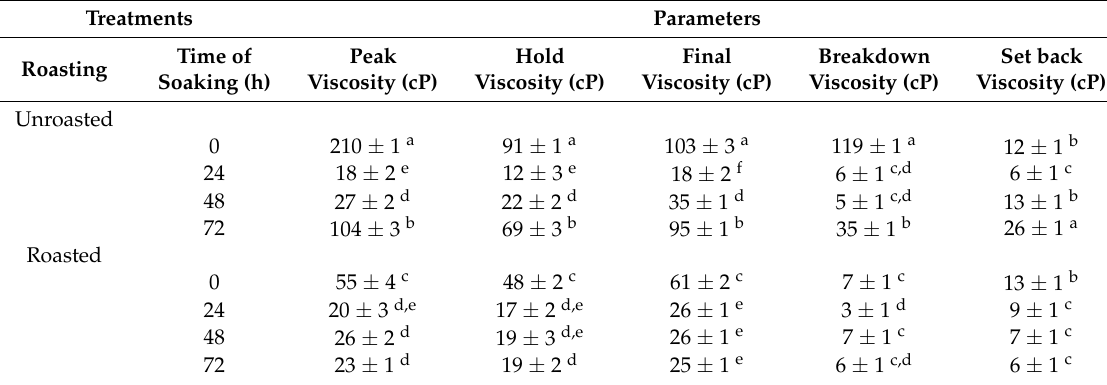
Figure 5. Viscoamylograph profiles of ( A ) unroasted; and ( B ) roasted soaked and unsoaked soybean flour. Table 2. Pasting properties of soy flour as affected by roasting and soaking time.